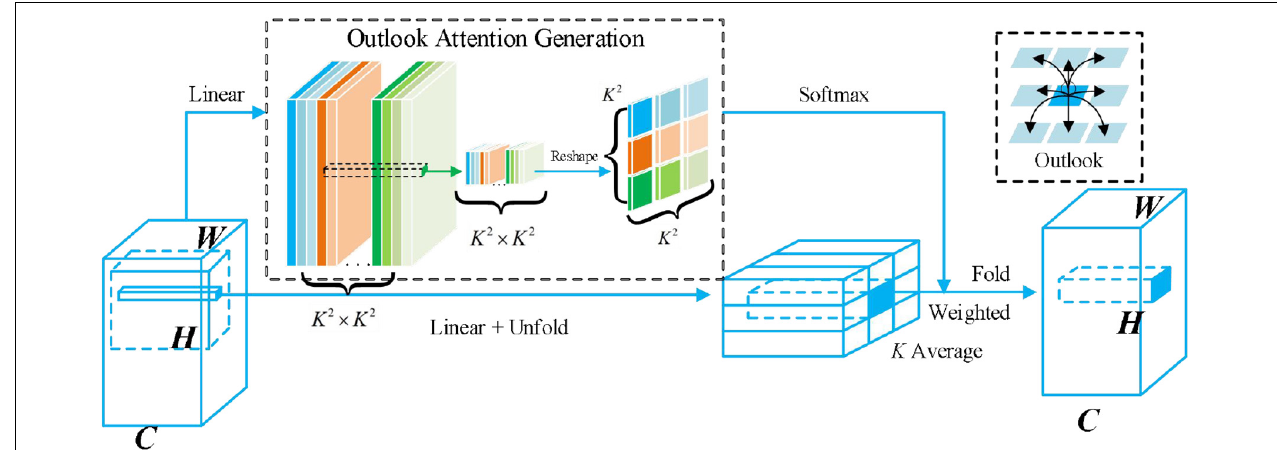
FIGURE 7 | Illustration of outlook attention. The outlook attention matrix for a local window of size K*K can be simply generated from the center token with a linear layer followed by a reshape operation. The attention weights are generated from the center token within the window and act on the neighbor tokens and itself.